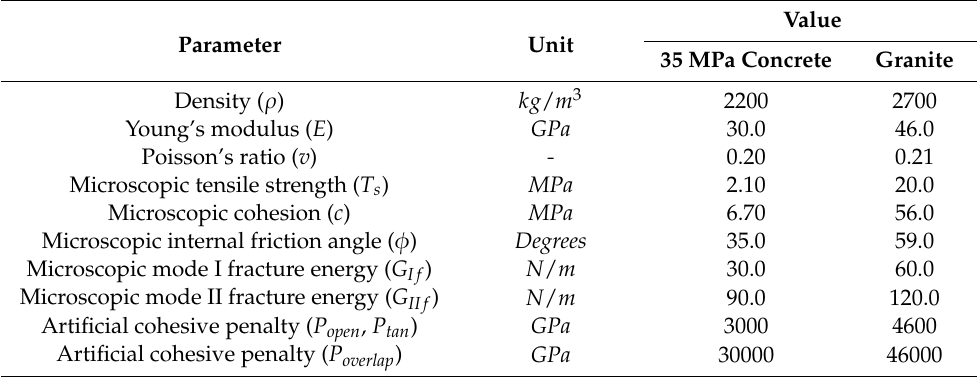
Figure 8. Comparison of FDEM numerical simulation and experiment of the BTS test of concrete under quasi-static loading: ( a ) plot of axial stress versus axial displacement and ( b ) final fracture pattern from the numerical simulation and experimental test. Table 2. Calibrated FDEM input parameters for the simulation of fracture behaviors of concrete and rock elements in the direct shear tests. Note that the loading platens are rigid in Section 3 while elastic in Section 4.